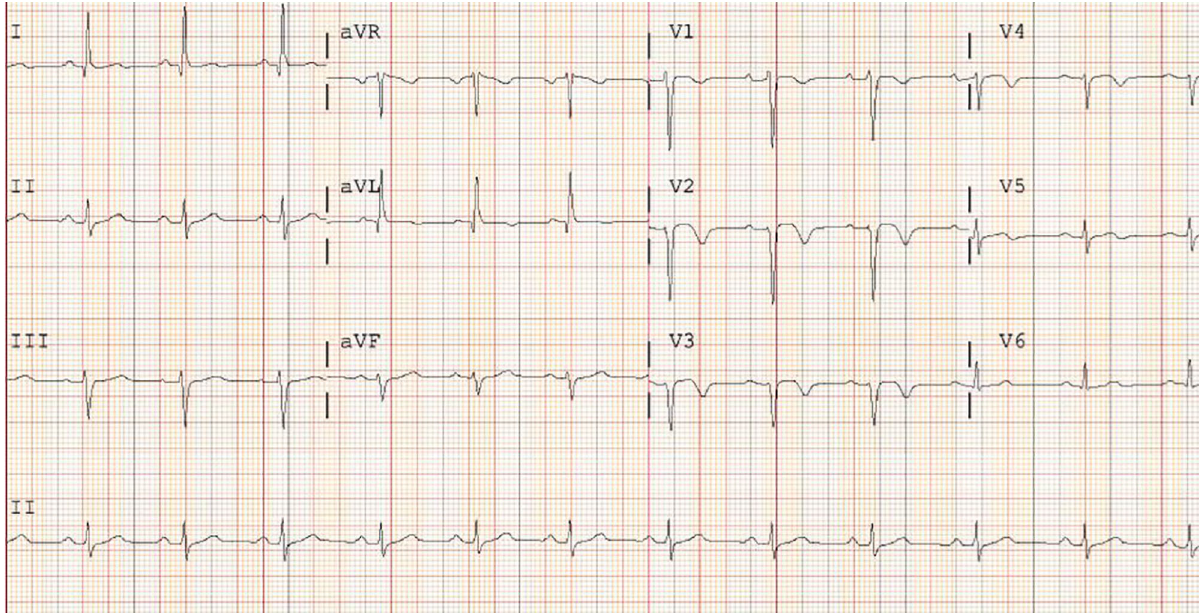
Figure 3: Repeat ECG on day 2 of hospitalization showing the expected evolution of anterior STEMI with QS waves and T-wave inversions seen in